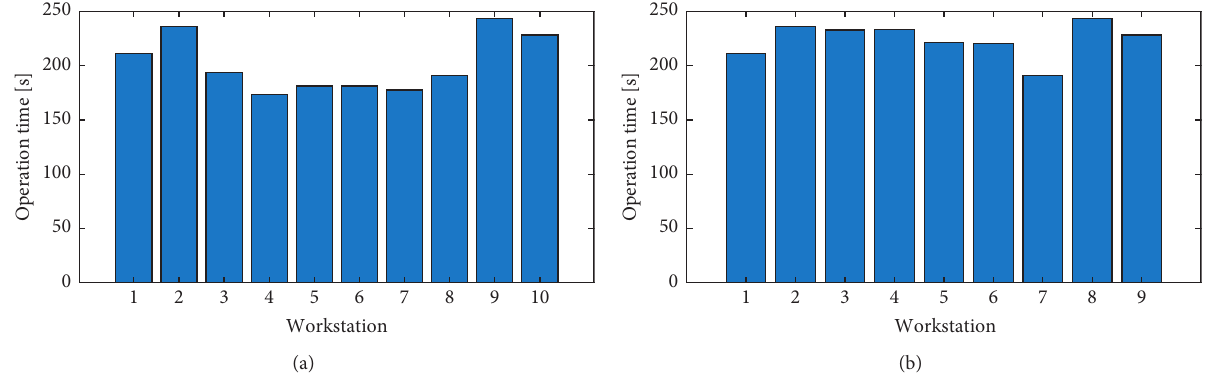
Figure 18: The evolution of manufacturing time during assembly of the p (b) After line balancing.